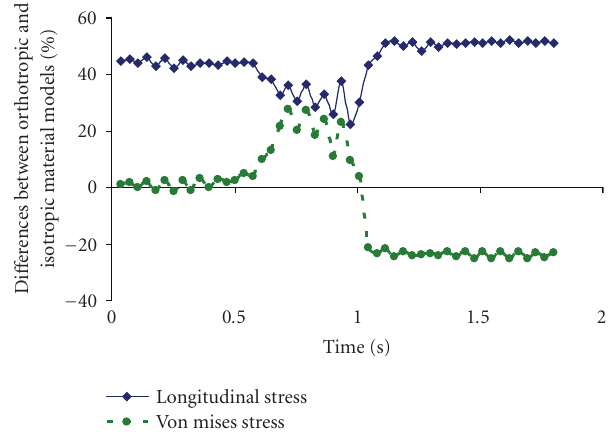
Figure 10: The material model e ff ect on longitudinal and von Mises stresses during the